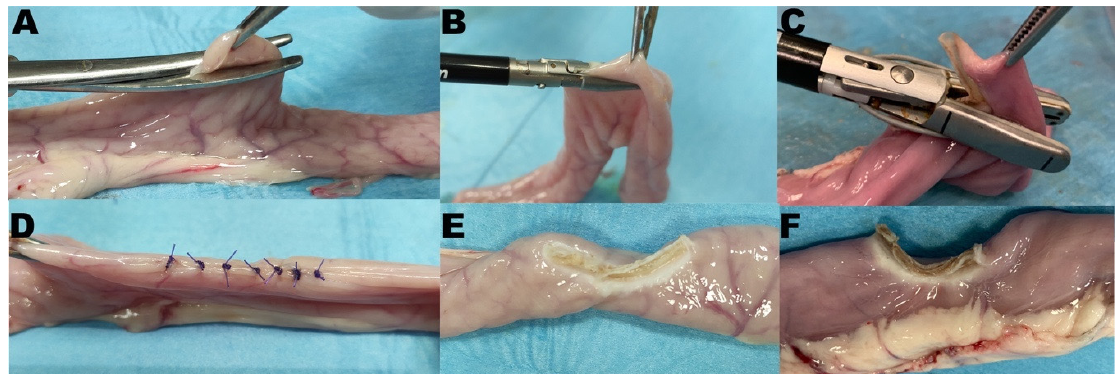
Figure 4. Representative pictures of biopsy procedure in study arm 2. Top row, during applica- tion; bottom row, after biopsy. A,D: Group Suture; B,E: Group radiofrequency vessel-sealing ( A , D ) Group Suture; ( B , E ) Group radiofrequency vessel-sealing (RFVS)-1; ( C , F ) Group (RFVS)-1; C,F: Group RFVS-3.